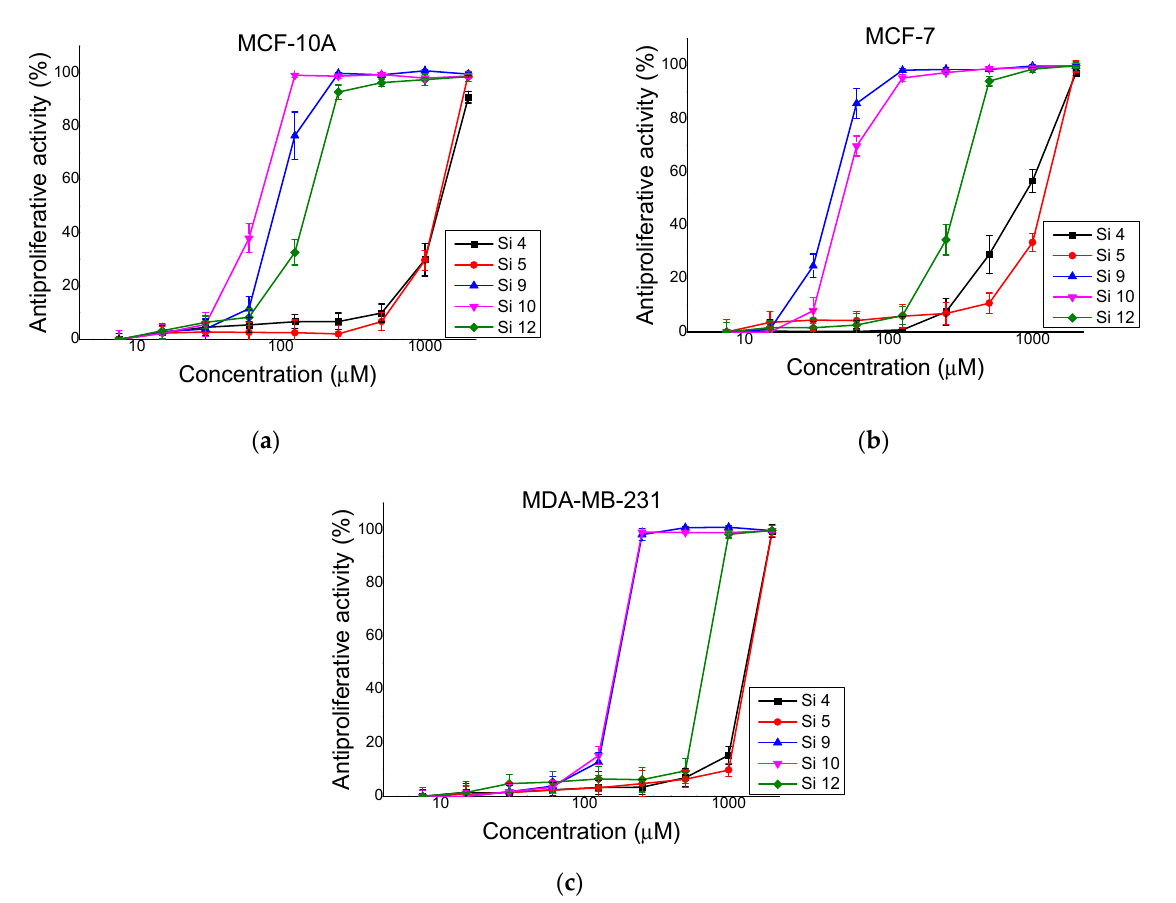
Figure 2. Antiproliferative activity of newly synthesized compounds. Dose–response curves assessment in ( a ) breast, ( b ) mammary gland type A adenocarcinoma (MCF-7) and ( c ) triple-negative breast cancer (MDA-MB-231). Values are means ± standard deviation from three independent experiments, n = 6.